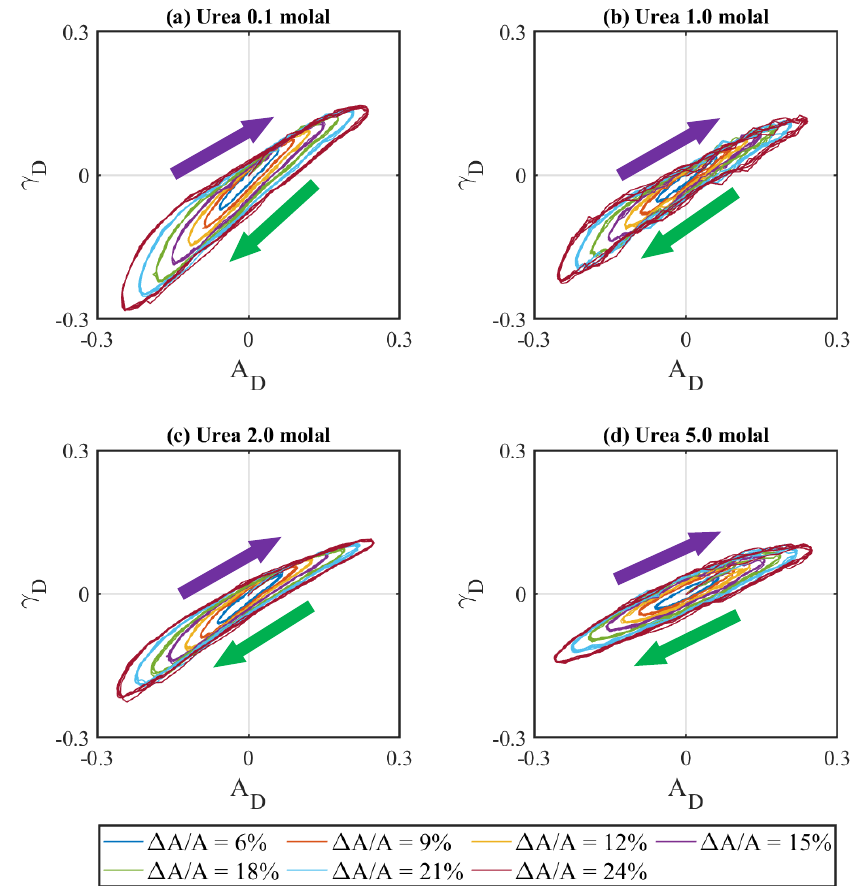
Figure 4. Effect of urea on the Lissajous plot of the adsorbed layers from lipase 2 mg · mL − 1 solution with urea concentrations of 0.1, 1.0, 2.0, and 5.0 molal by oscillations of 0.05 Hz frequency and different amplitudes; the compression and expansion paths are denoted with green and purple arrows, respectively; ∆ A / A for Lissajous plots from inside towards outside are 6% (blue), 9% (orange), 12% (yellow), 15% (purple), 18% (green), 21% (light blue), and 24% (red), respectively; solid lines are used for better visualization of experimental results.